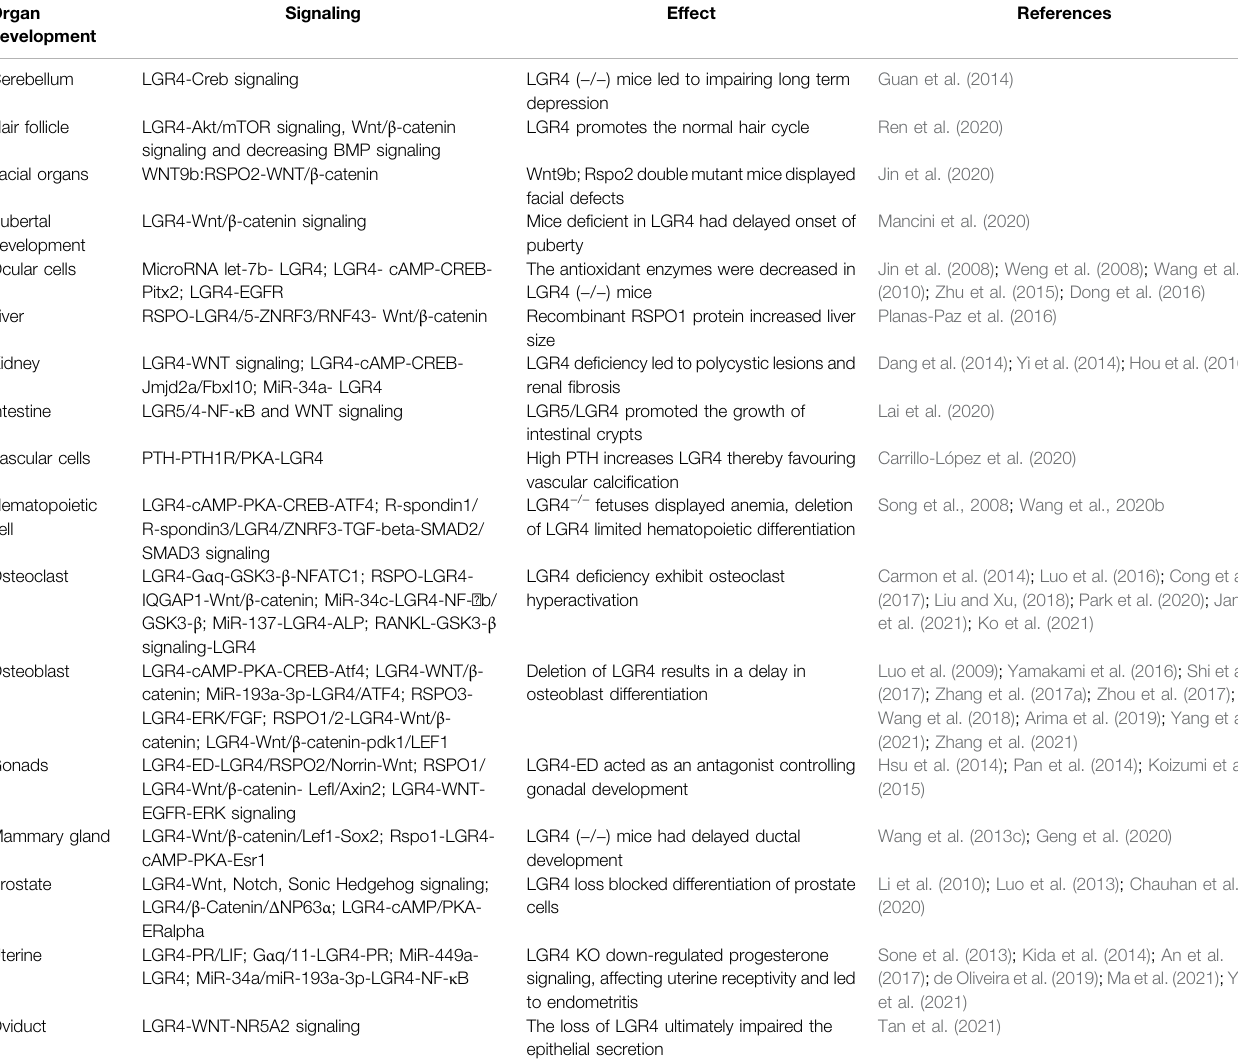
TABLE 1 | Diverse roles of LGR4 in organ